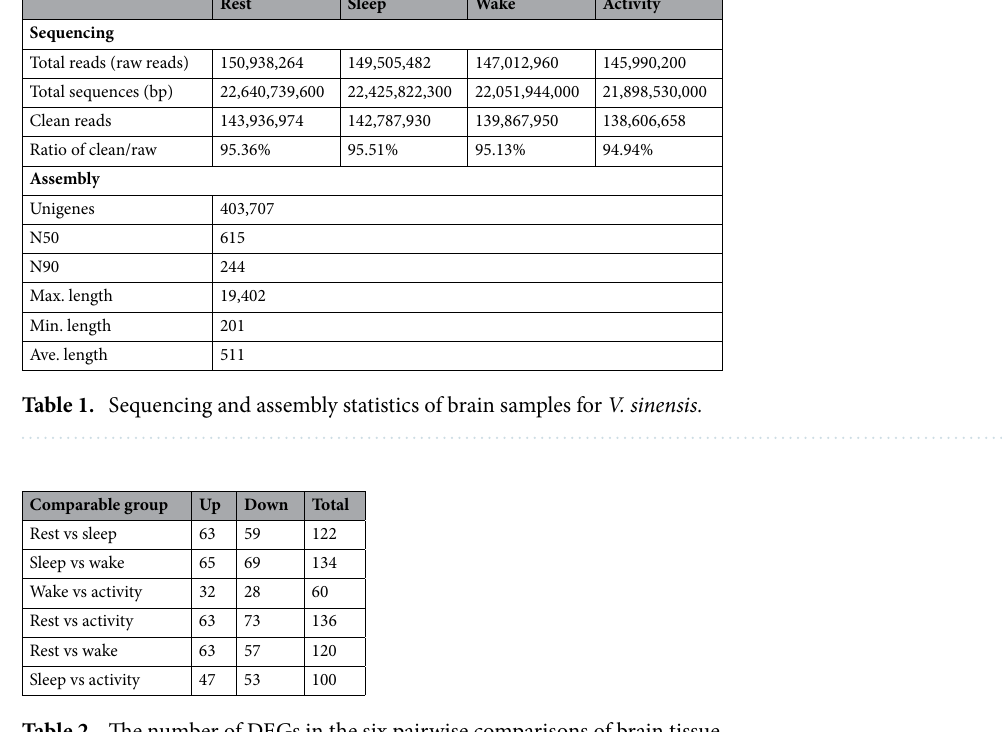
Table 2. The number of DEGs in the six pairwise comparisons of brain tissue.